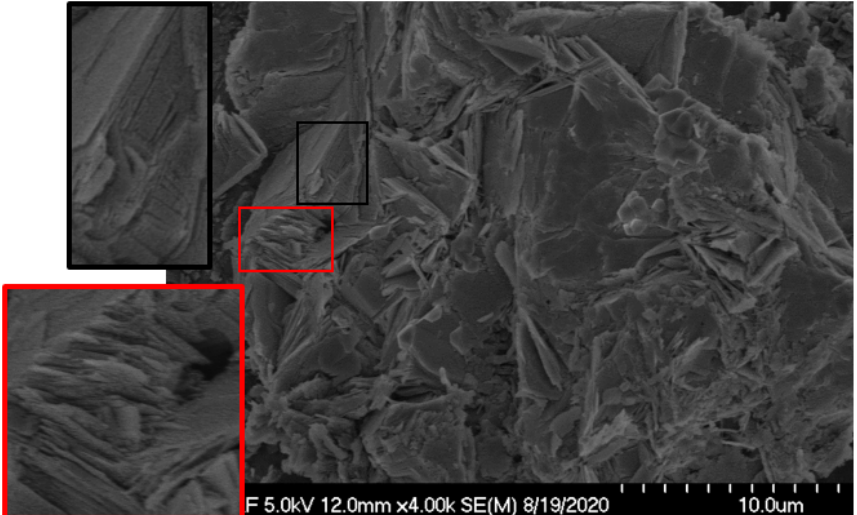
Figure 5. SEM image showing the fractures and cracks formed after adsorption, which are highlighted in the red boxes.